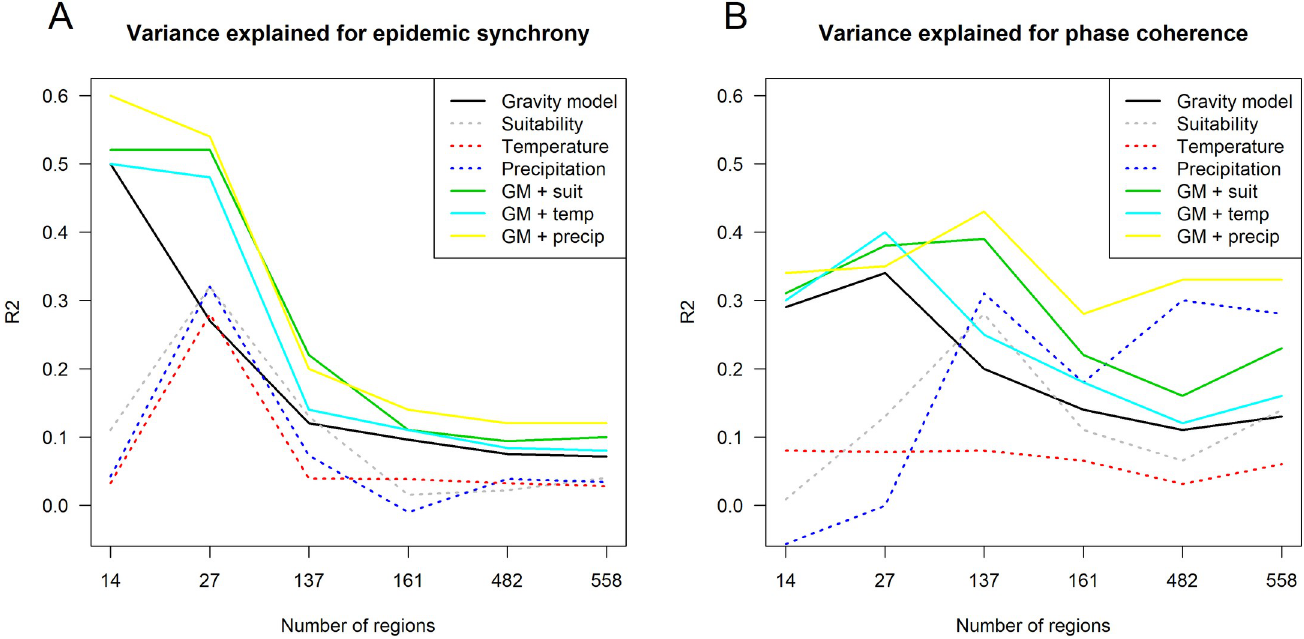
Fig 4. Variance explained for models of epidemic synchrony and annual phase coherence. R 2 for epidemic synchrony (A) and annual phase coherence (B) predicted by models 4–10 depending on the spatial scale considered.